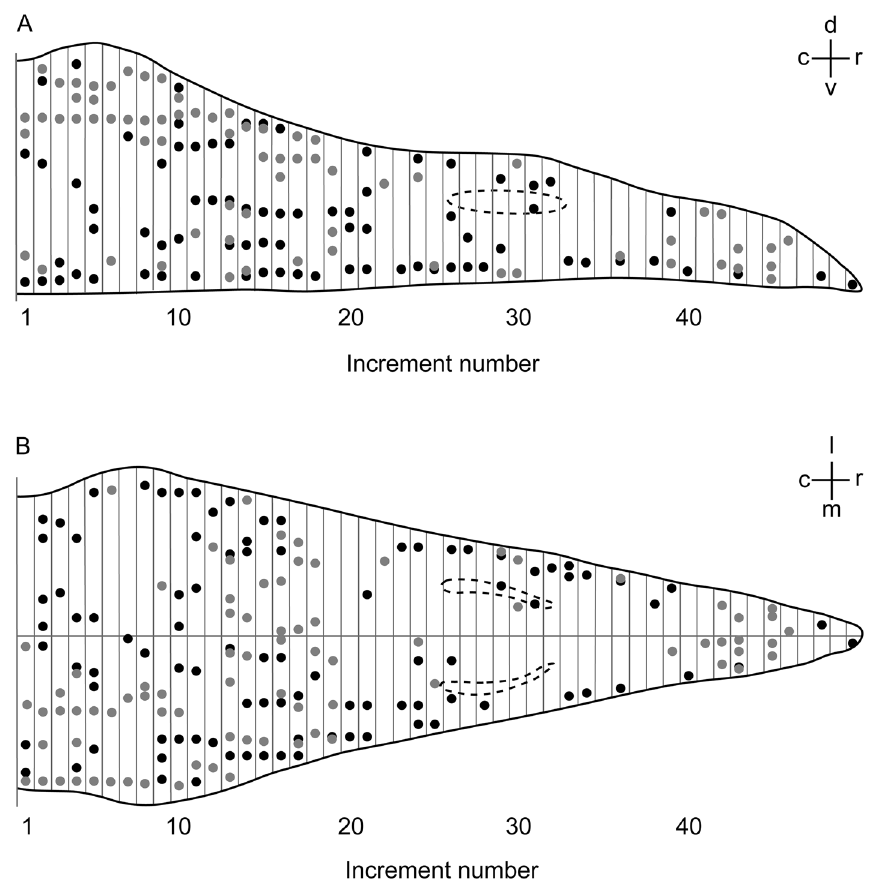
Figure 3. Distribution of Prussian blue (PB) positive sites in the upper beak of Eurasian blackcaps. PB positive sites are shown along the ( A ) dorso-ventral axis and ( B ) medio-lateral axis of the upper beak in 50 250 µm-increments from caudal to rostral. Each dot represents PB positive sites. Black and grey dots represent two different individuals. Dashed lines represent the location of the nostrils. Abbreviations: c, caudal; d, dorsal; l, lateral; m, medial; r, rostral; v